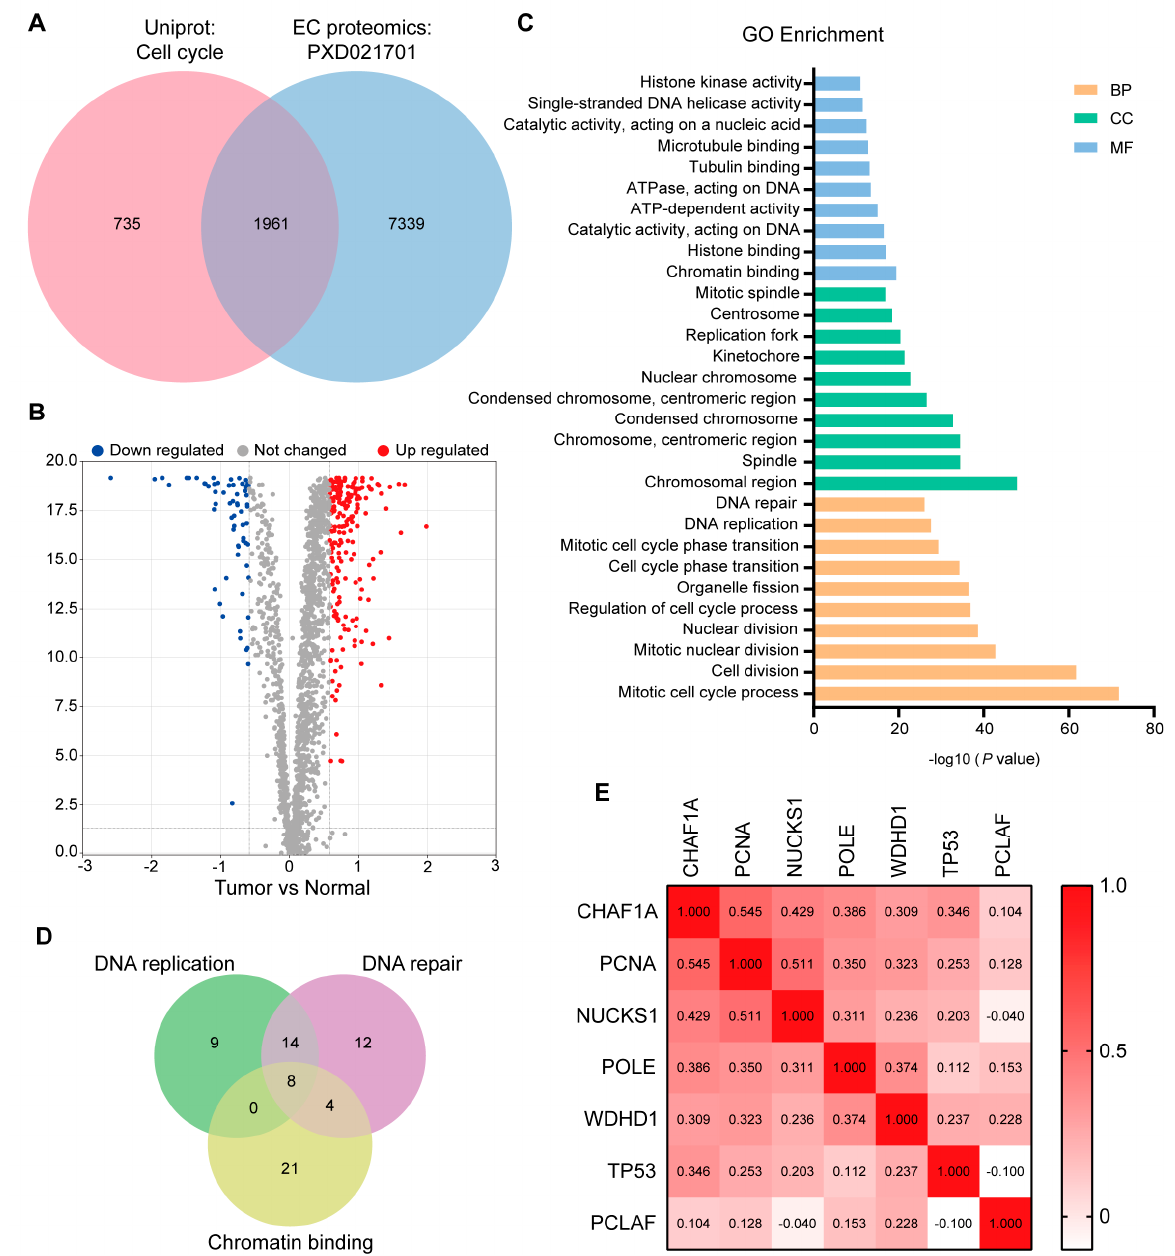
Figure 1. Screening of key DNA replication and DNA repair proteins by proteomic analysis. ( A ) Overlap between the “Cell Cycle” protein list in the Uniprot database and the EC proteome list. ( B ) Volcano plot showing proteins up − (red) or down − regulated (blue) in tumors. Gray dots represent other proteins. Fold change > 1.5, p − value < 0.01. ( C ) Gene Ontology (GO) enrichment analysis of proteins up-regulated in EC. BP: biological processes, CC: cellular components. MF: molecular func- tions. ( D ) Overlap between three gene subsets obtained by GO enrichment analysis: DNA replica- tion, DNA repair, and chromatin binding. ( E ) Spearman correlation analysis was performed on seven proteins after the incomplete expression or the no signi fi cant survival analysis of eight pro- teins in ( D ) had been removed.